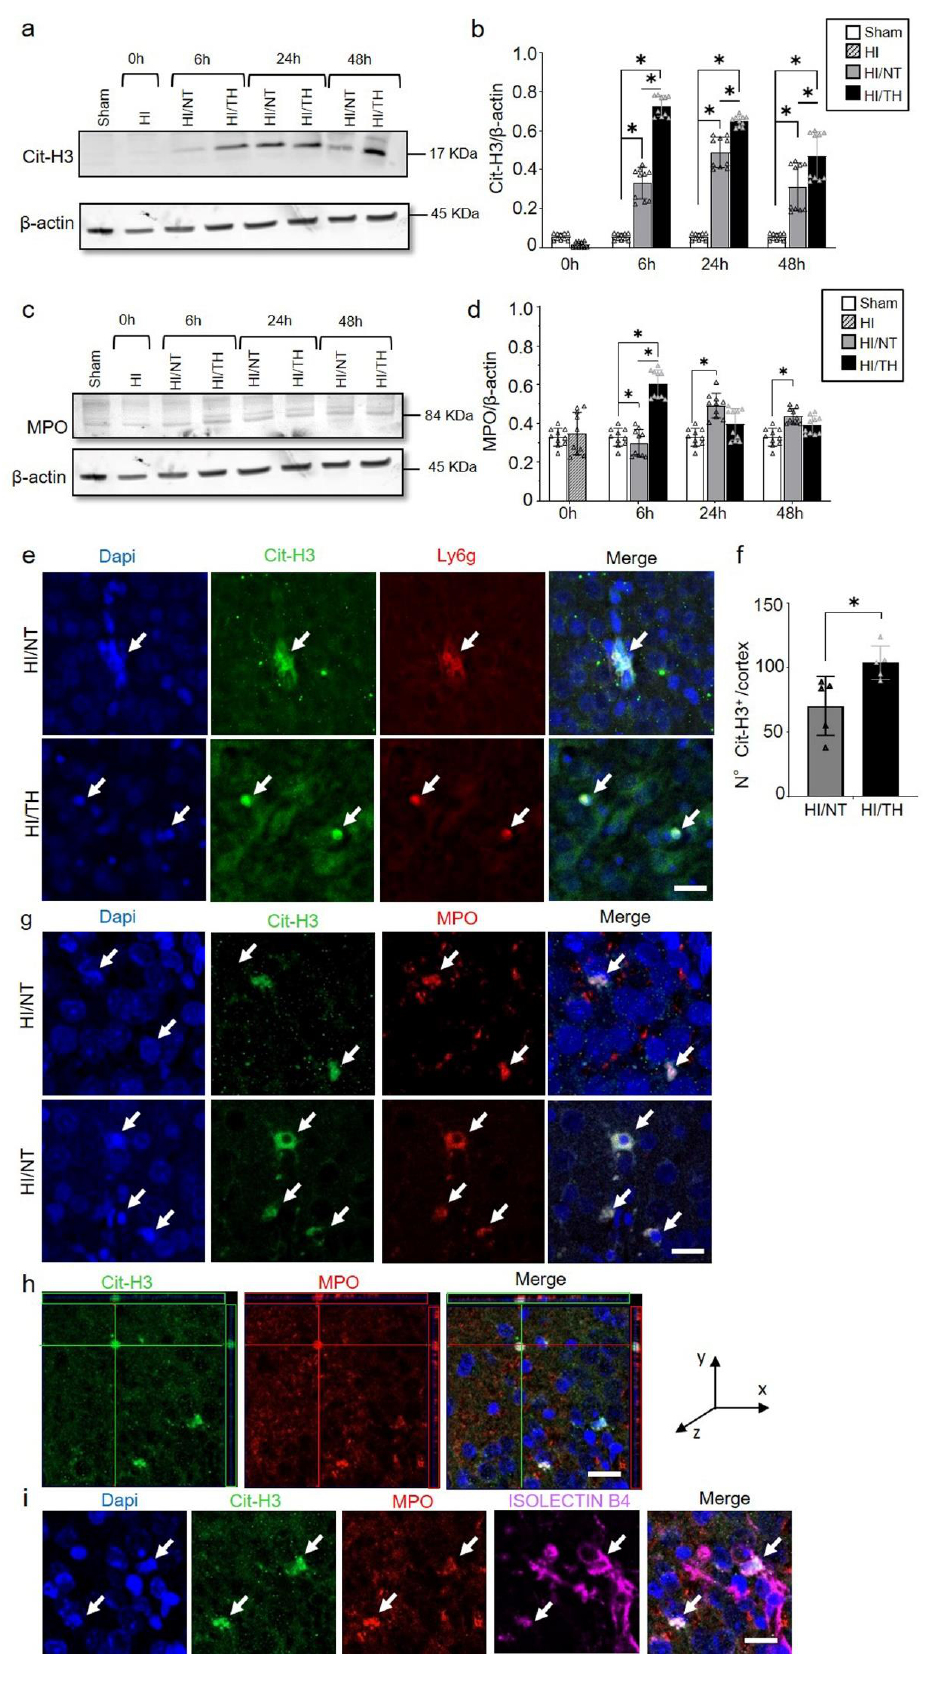
Figure 3. Temporal expression of NETosis in the ipsilateral brain samples after HI-NT or